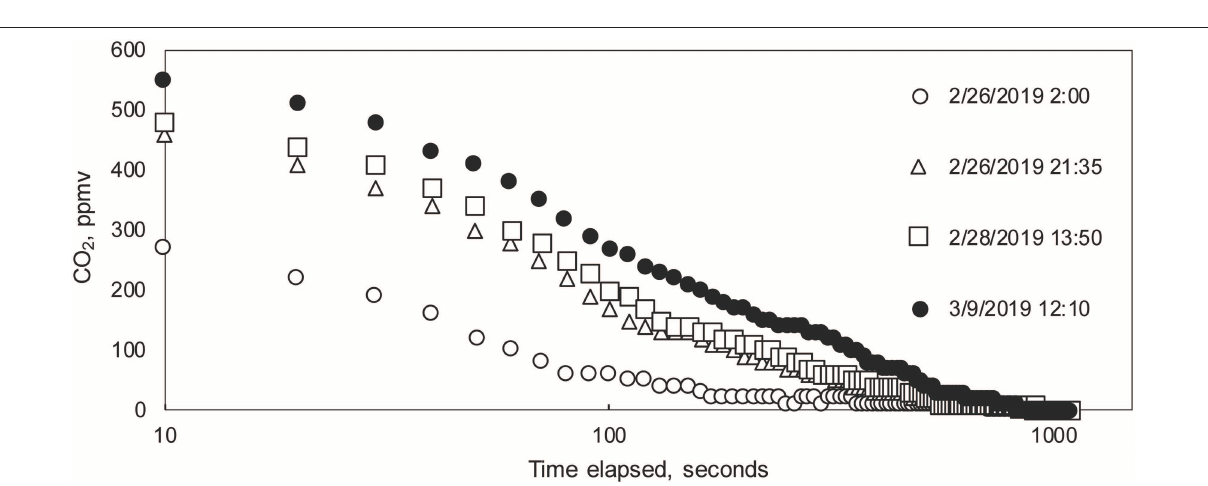
FIGURE 6 | Progressive change in PCO 2(stream) stabilization curves through monitoring